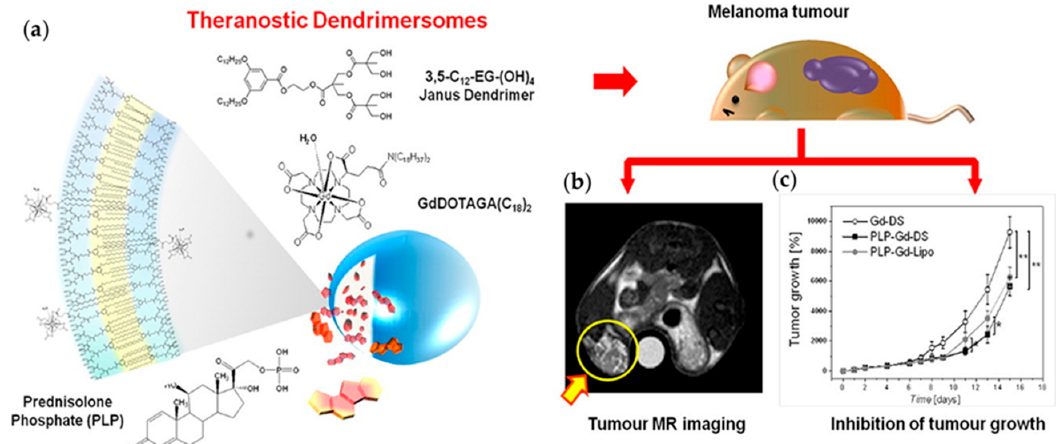
Figure 14. ( a ) Structures of the components of theranostic dendrimersomes: JD 3,5-C 12 -EG-(OH) 4 , the GdDOTAGA(C 18 ) 2 complex (MRI contrast agent incorporated in the membrane bilayer) and the antitumour drug prednisolone phosphate (PLP). ( b ) Representative in vivo MR image showing the tumor after injection of dually-loaded DSs. ( c ) Time course of the tumour growth expressed as the percentage volume increase with respect to the initial tumor volume calculated at time 0 after the systemic administration of the control single-loaded DSs (Gd-DS, white circles), dual-loaded dendrimersomes (PLP-Gd-DS, black squares) or liposomes (PLP-Gd-Lipo, gray circles). Copyright Elsevier, reprinted from Journal of Controlled Release 2017 [81].